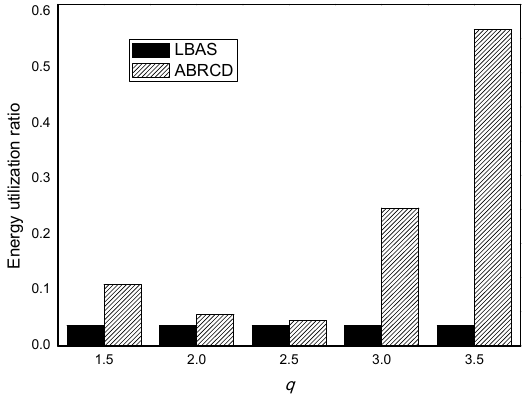
Figure 26. Energy utilization ratio with different q.